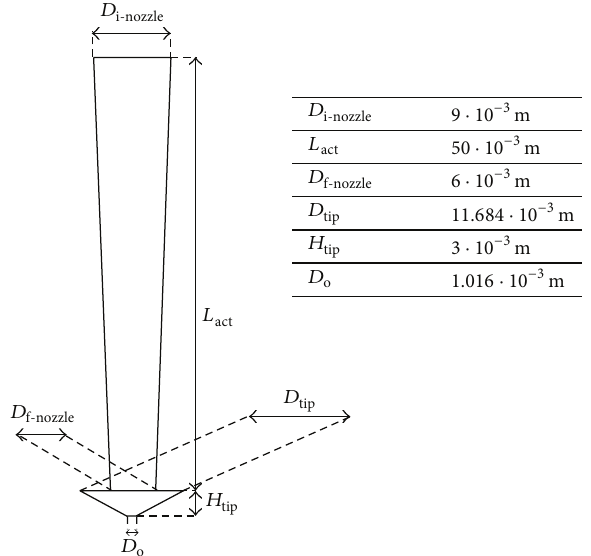
Figure 4: Nozzle geometry with quoted dimensions.